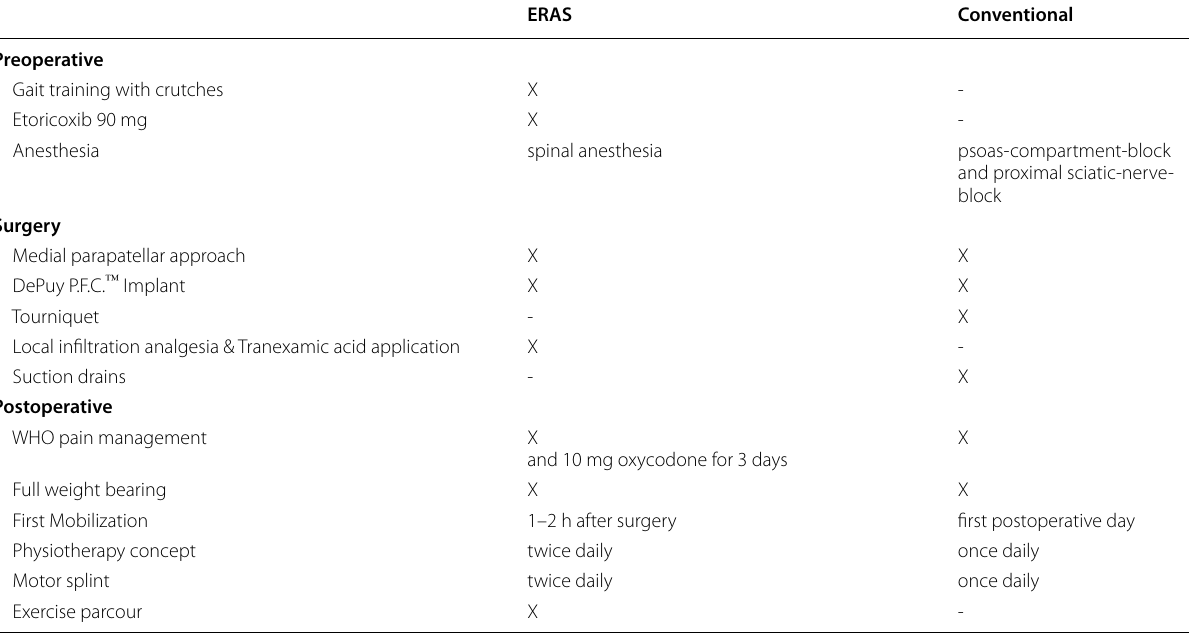
Table 1 Summary of preoperative, operative, and postoperative differences between the ERAS group and the conventional